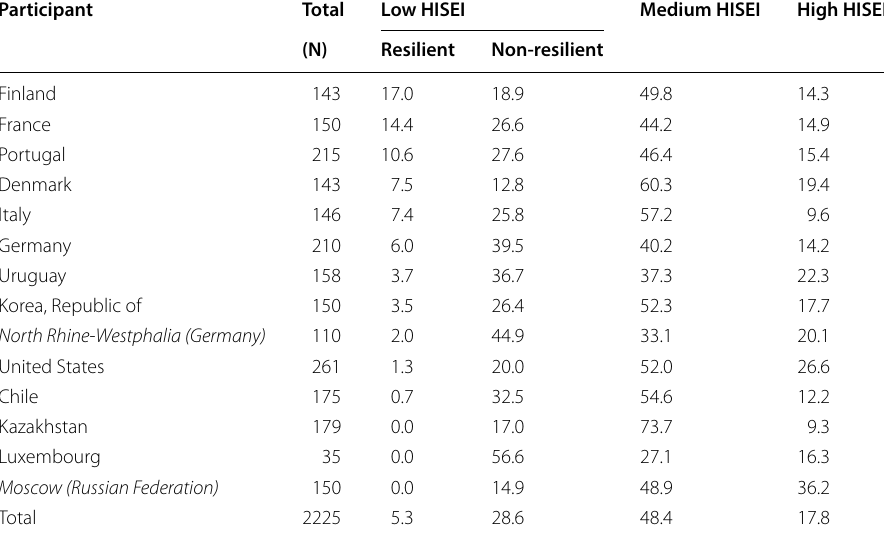
Differences to 100% are justified in the rounding process Table 4 Descriptive statistics of those school characteristics used to develop a typology of resilient schools in IEA‑ICILS 2018 (aggregated data from the teacher questionnaire) Characteristic